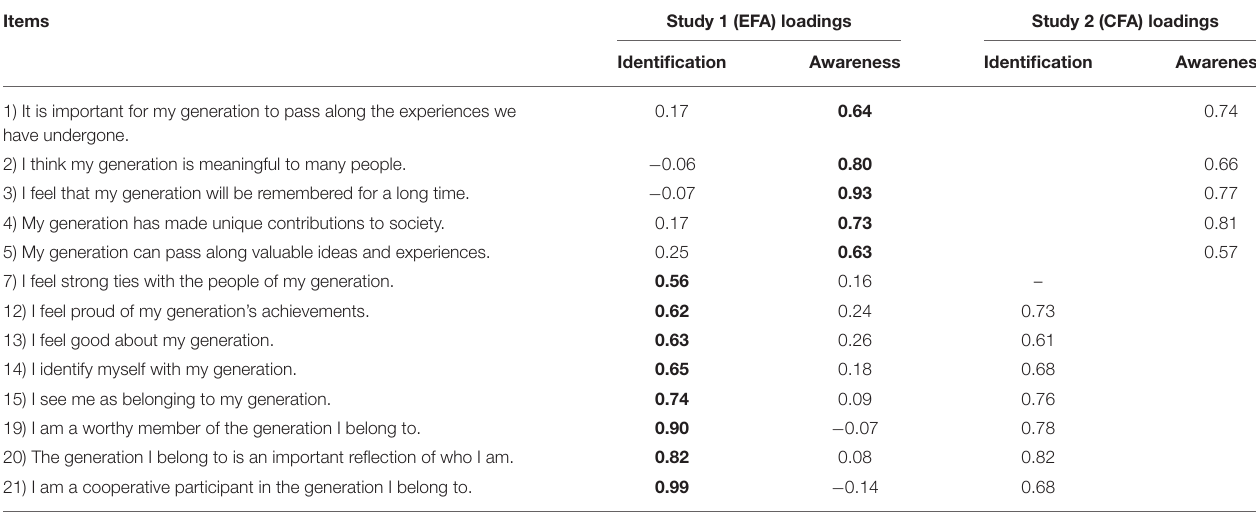
300) and study 2 (CFA, N =